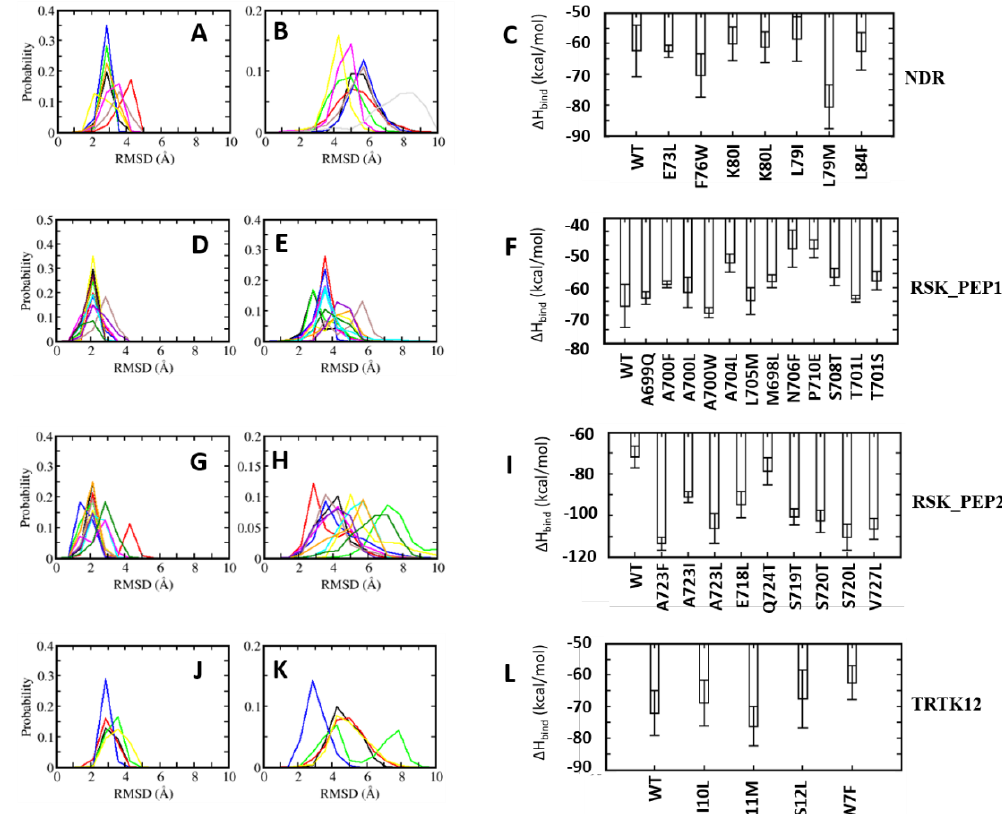
Figure 6. Distribution of root mean square deviation (RMSD) of ( A , D , G , J ) S100B( ββ ) and ( B , E , H , K ) the bound peptides (( A , B ): S100B( ββ )-NDR; ( D , E ): S100B( ββ )-RSK_PEP1; ( G , H ): RSK_PEP2; ( J , K ): S100B( ββ )-TRTK12 complexes). Different colours correspond to the different mutations in the peptide (NDR (black: WT, red: E73L, green: F76W, blue: K80I, yellow: K80L, brown: L79I, magenta: L79M, grey: L84F), RSK_PEP1 ( black: WT, red: A699Q, green: A700F, blue: A700L, yellow: A700W, brown: A704L, magenta: L705M, orange: M698L, cyan: N706F, violet: P710E, dark green: S708T, turquoise: T701L, maroon: T701S), RSK_PEP2 (black: WT, red: A723F, green: A723I, blue: A723L, yellow: A723W, brown: E718L, cyan: Q724T, magenta: S719T, orange: S720I, violet: S720L, dark green: V727L), TRTK12 (black: WT, red: I10L, green: L11M. blue: S12L, orange: W7F)). ( C , F , I , L ) Binding free energies of the interactions of S100B( ββ ) with each peptide were calculated with the MMPBSA approach (see Methods) using the conformations sampled during the MD simulations of the S100B( ββ )-stapled peptide